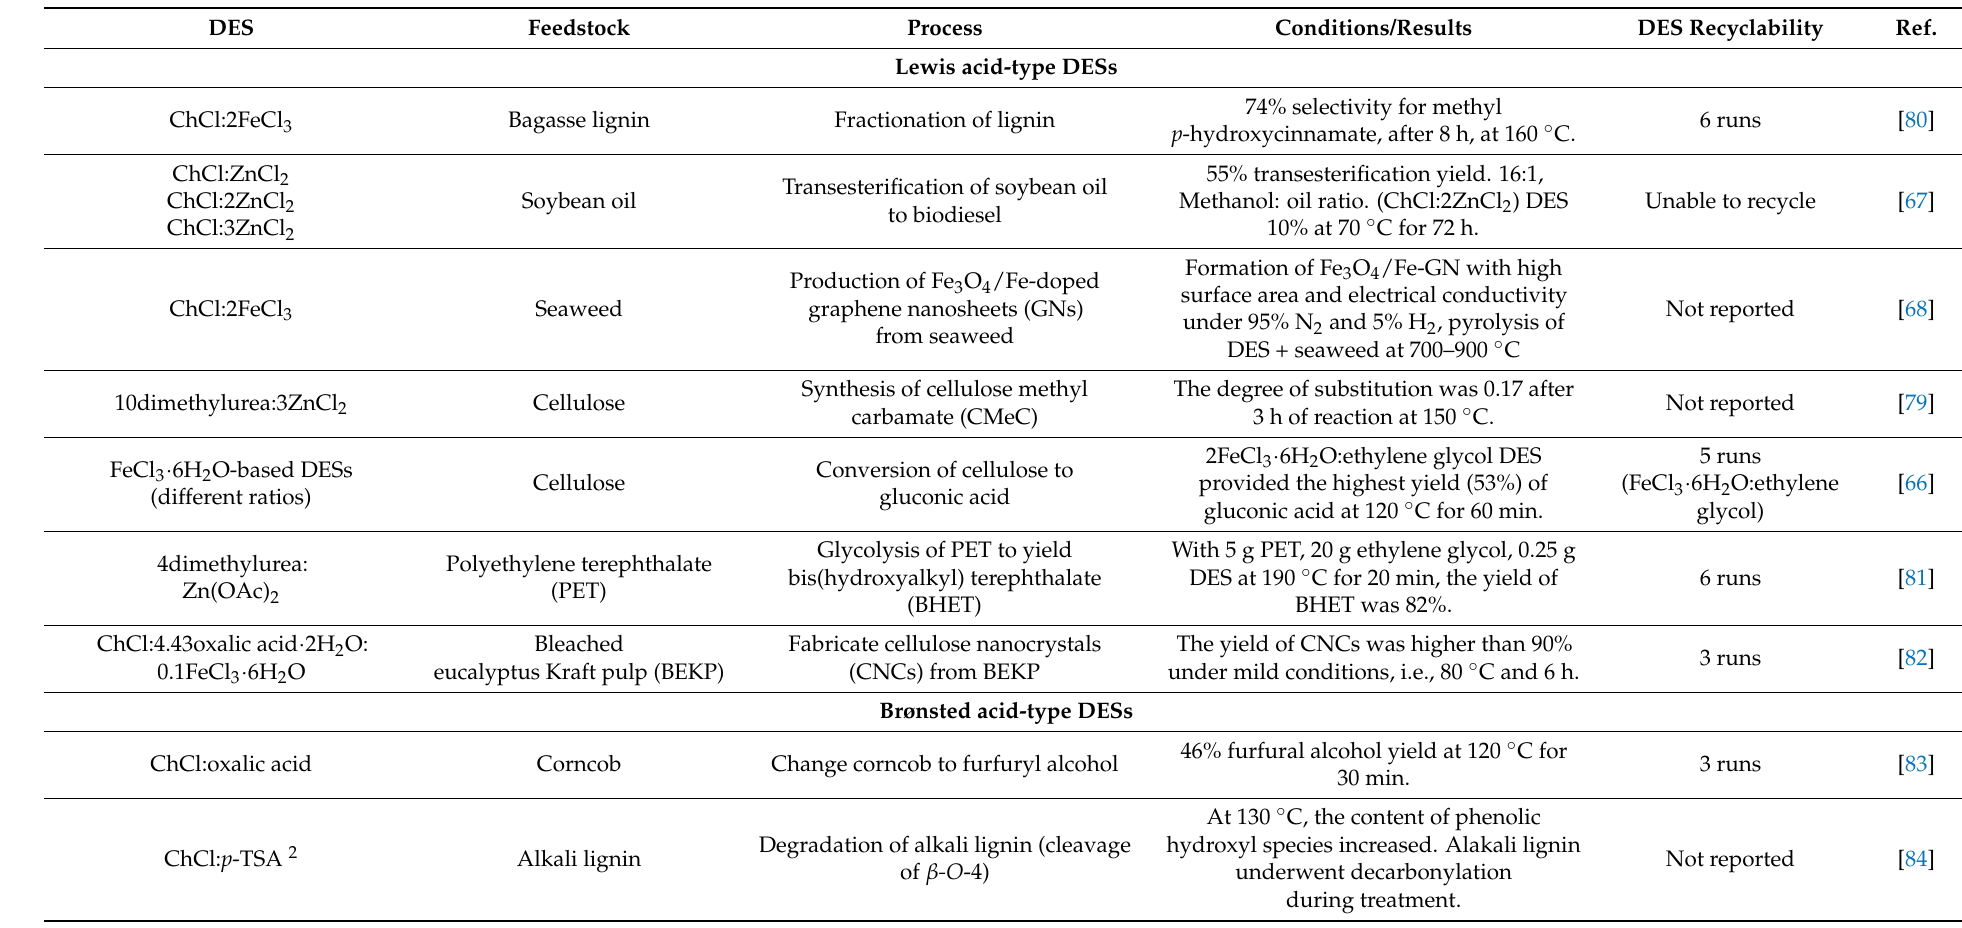
Table 1. Catalytic DESs used in biomass